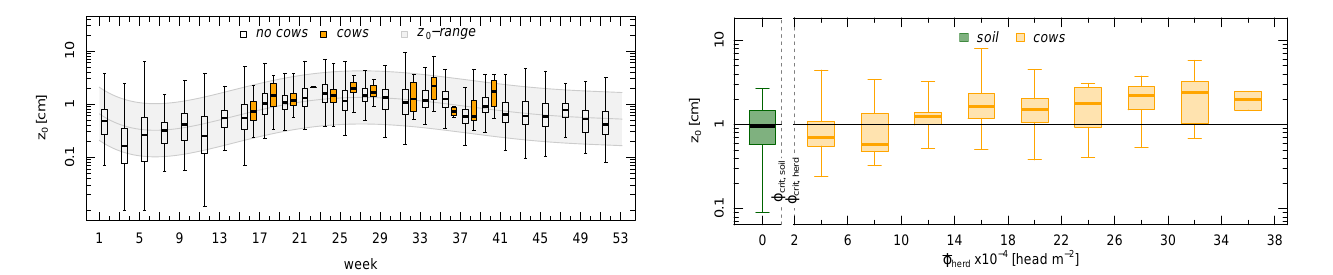
Figure 7. Fortnightly distributions (box plots) of calculated rough- ness length ( z 0 ) for wind speeds > 1.5ms − 1 separated for cases with no cows in the FP (white boxes) and cases with cows present in the FP (orange). Whiskers for the cow cases cover the full data range, outliers for no cows cases are not shown. The gray area in- dicates the z 0 range where the 30min z 0 value was accepted for FP evaluation. The middle curve in the gray range represents the sixth-order polynomial fit to the values without cows.